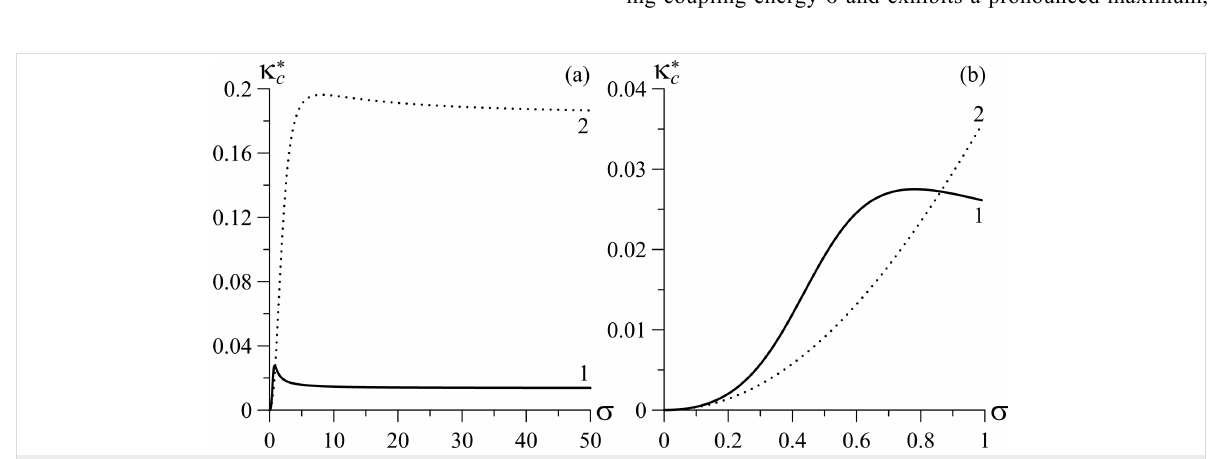
Figure 4: The tricritical segregation parameter for the Fréedericksz transition as a function of the coupling energy of CNTs with the LC matrix, σ , for different values of the parameter γ for k = 1.5: curve 1 – γ = 0.1; curve 2 – γ = 0.5. (a) Large scale and (b) small